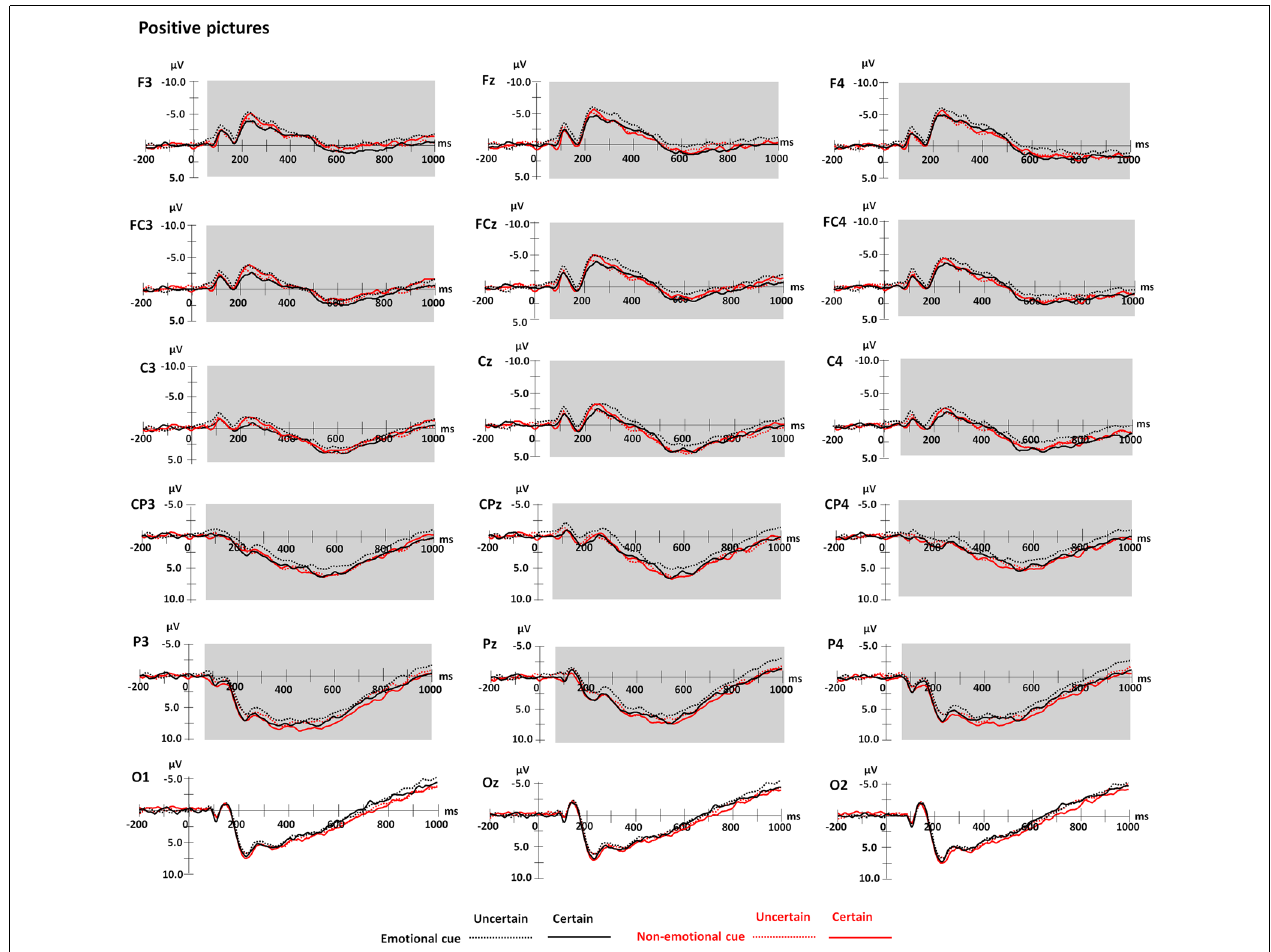
FIGURE 4 | Grand average waveforms for positive pictures varying in cue valence, cue uncertainty, and emotion. Shaded areas represent the time windows for frontocentral and centroparietal ERPs (60–1,000